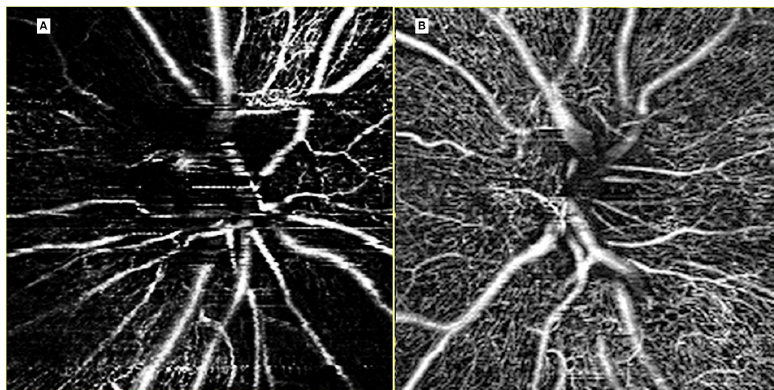
Figure 15. OCTA imaging of the peripapillary area. The radial peripapillary capillary plexus (RPCP) of an eye affected by radiation optic neuropathy ( A ). Note the presence of peripapillary RPCP dropout. The contralateral healthy eye is showed in ( B ).